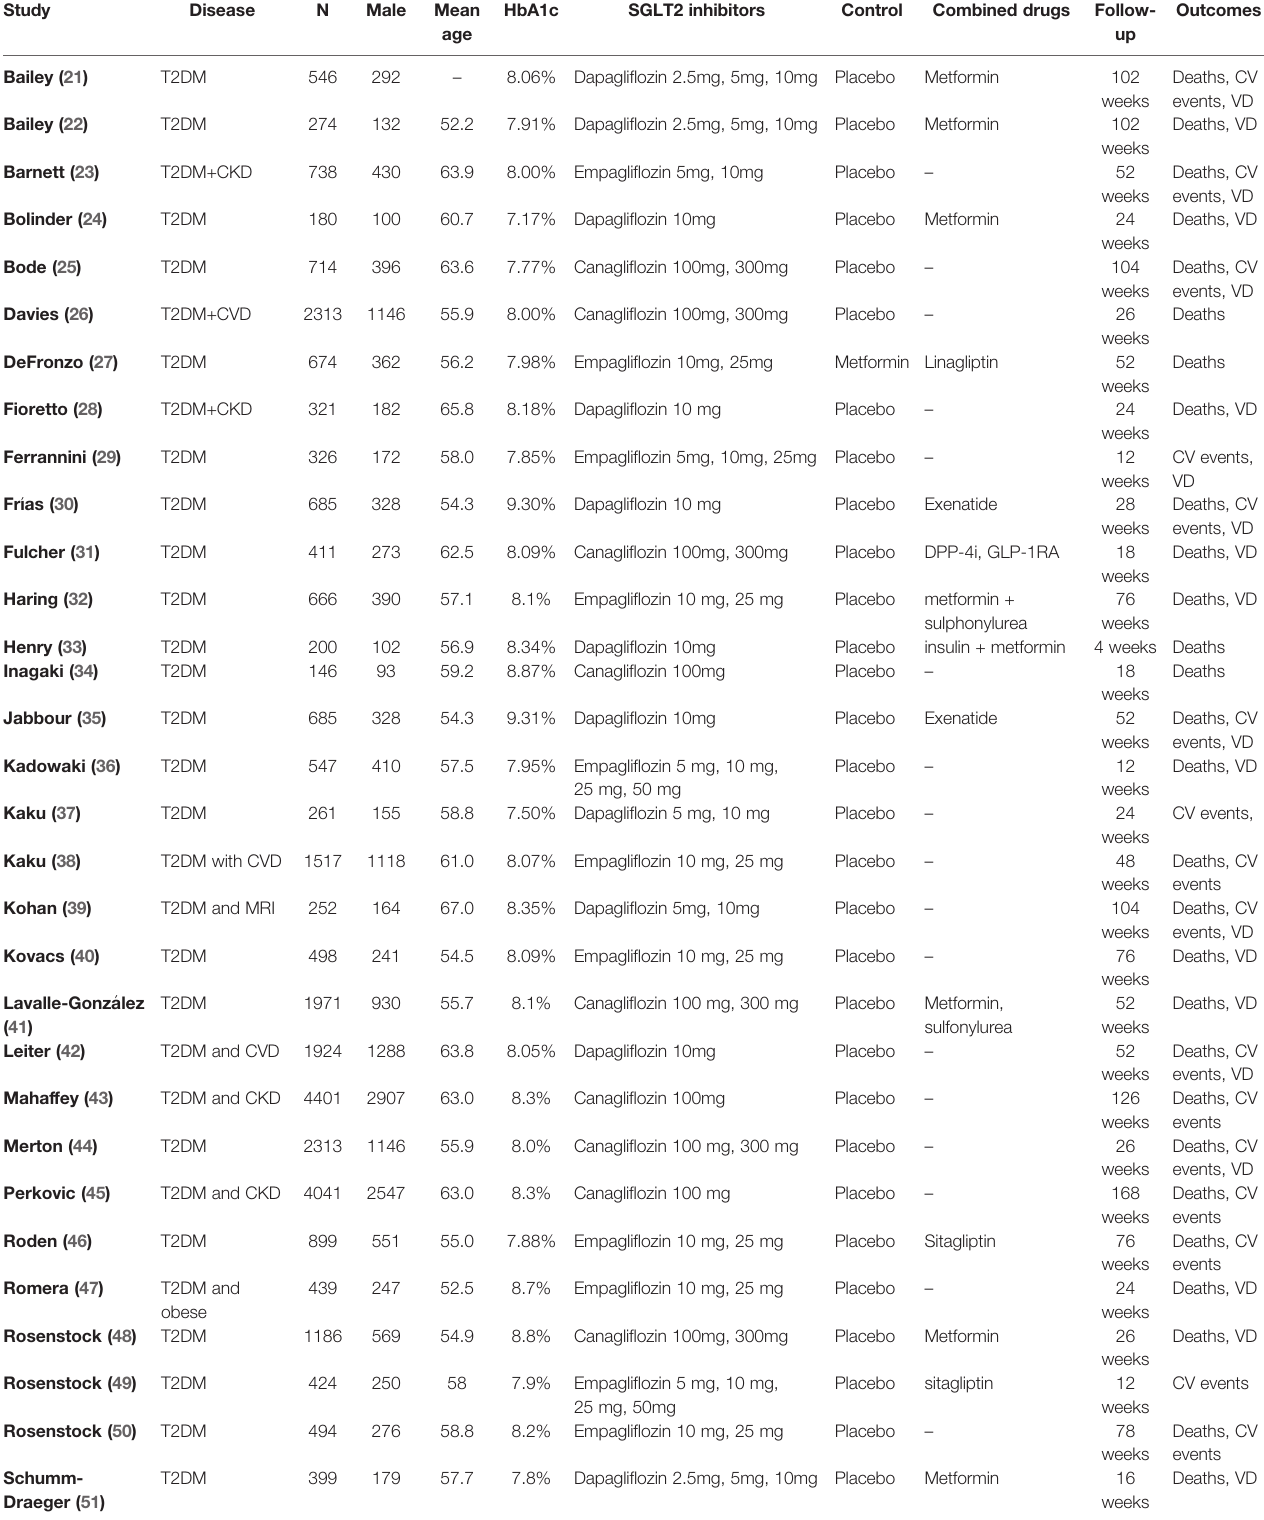
TABLE 2 | Baseline characteristics of included